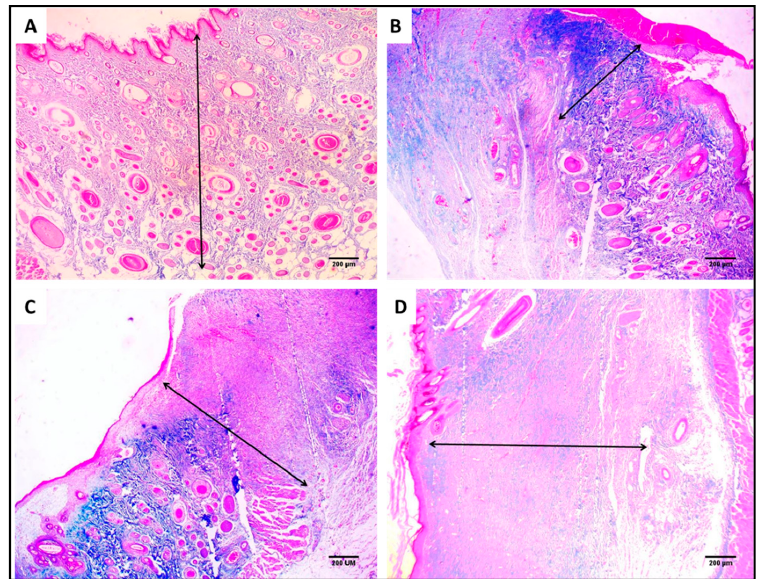
Figure 14. Masson’s trichrome staining of the wound showing the area of collagen fibers (%) using image J software of ( A ) section in normal skin (negative control) showing 28.2% area of collagen fiber (×40). ( B ) Section in the wound of the control group showing 8.2% area of collagen fiber (×40). ( C ) Section in the Betadine™-treated group showing 14.7% area of collagen fiber (×40). ( D ) Section in the AgNPs-treated group showing 22.4% area of collagen fiber (×40).